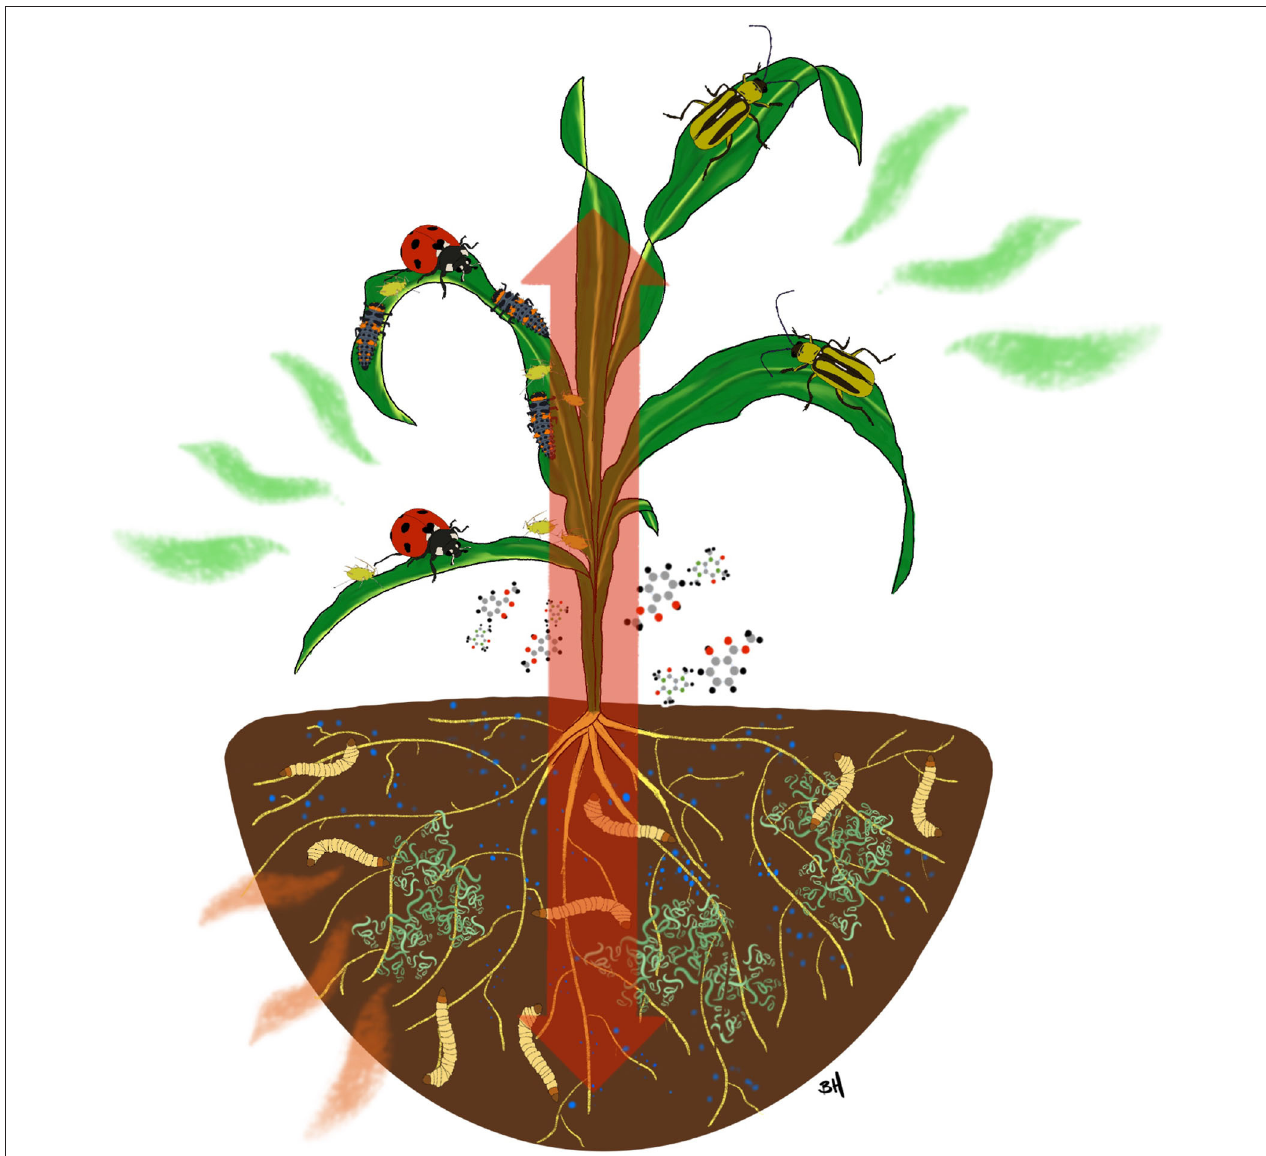
FIGURE 1 | Additions of biostimulants in the form of Plant Growth Promoting Bacteria and Humic Acids can have consequences for a range of other organisms including insect herbivores and insect natural enemies. Red arrow is meant to symbolize the systemic nature of many intra-plant communication systems that connect aboveground and belowground